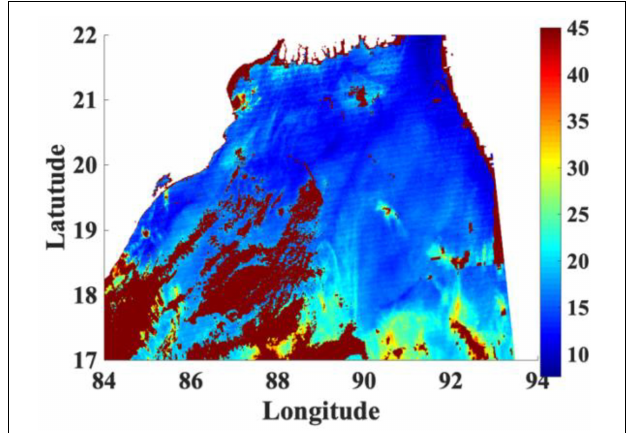
FIGURE 8 | Retrieved TCWV maps using PDSST for the same subset as in Figure 6A . The ranges of longitude and latitude from − 180 ◦ to 180 ◦ and from − 90 ◦ to 90 ◦ represent West to East and South to North, respectively. Unit of color bar is kg/m 2 . Dark brown color represents the “NaN”